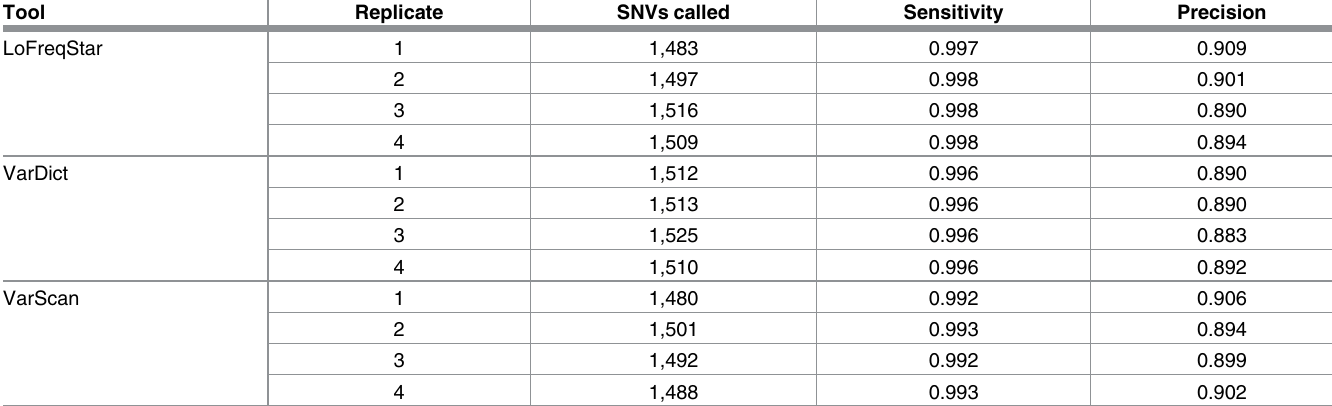
Table 2. Sensitivity and precision of LoFreqStar, VarDict and VarScan on GiaB referencesamples. The SNVs predictedby the algorithmwere com- pared to the goldenstandardSNVs providedby GiaB.